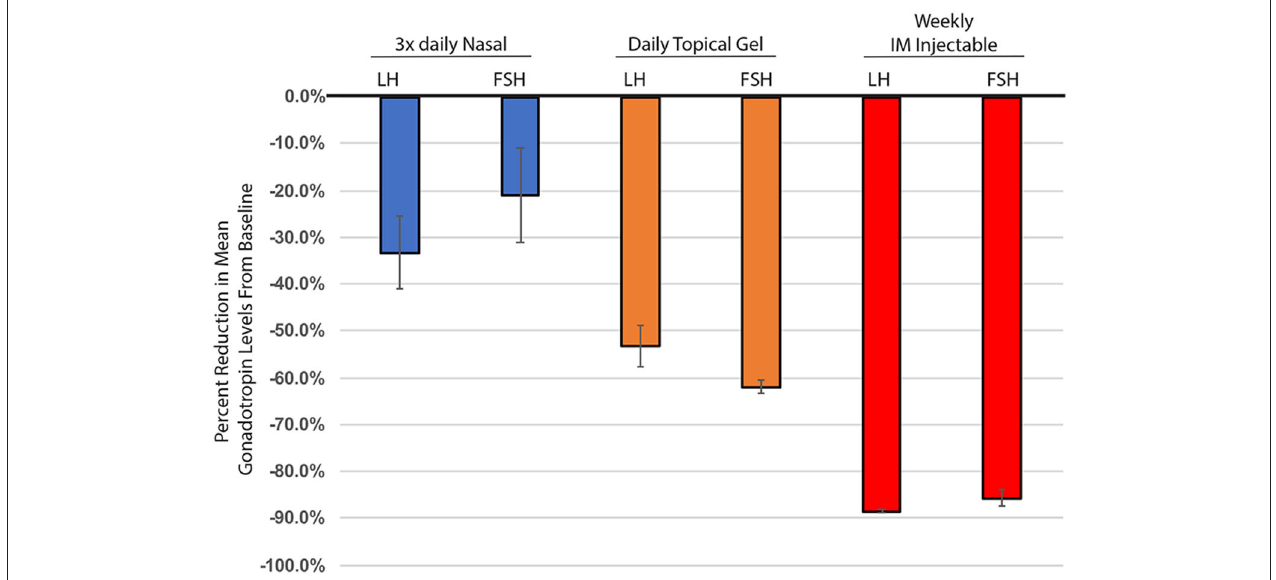
FIGURE 1 | Percent change in mean gonadotropin levels (LH & FSH), from baseline through 6 months of testosterone treatment. Nasal testosterone (blue), dosed t.i.d., adapted from (15), n = 33. Topical testosterone (orange), dosed daily, adapted from (9), n = 123. IM injectable - 100mg testosterone enanthate, (red), adapted from ( 10), n = 10. All changes from baseline were statistically significant. Nasal testosterone—FSH p = 0.03, all others p < 0.001. Standard error calculated using delta